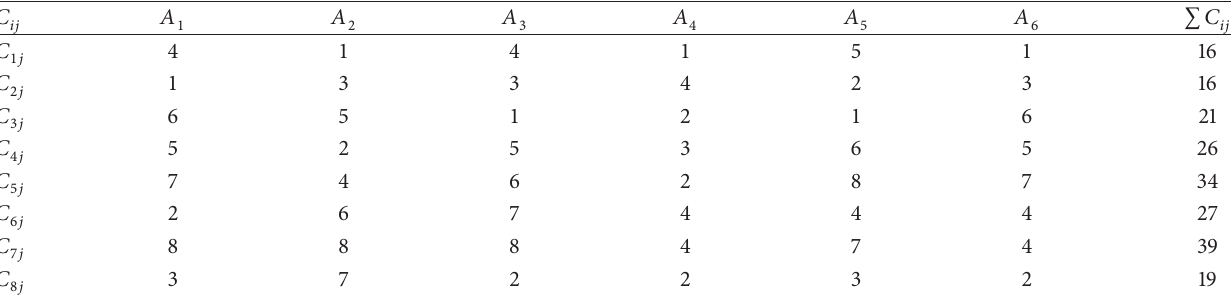
Table 6: Order values of index vectors with fixed index vectors.